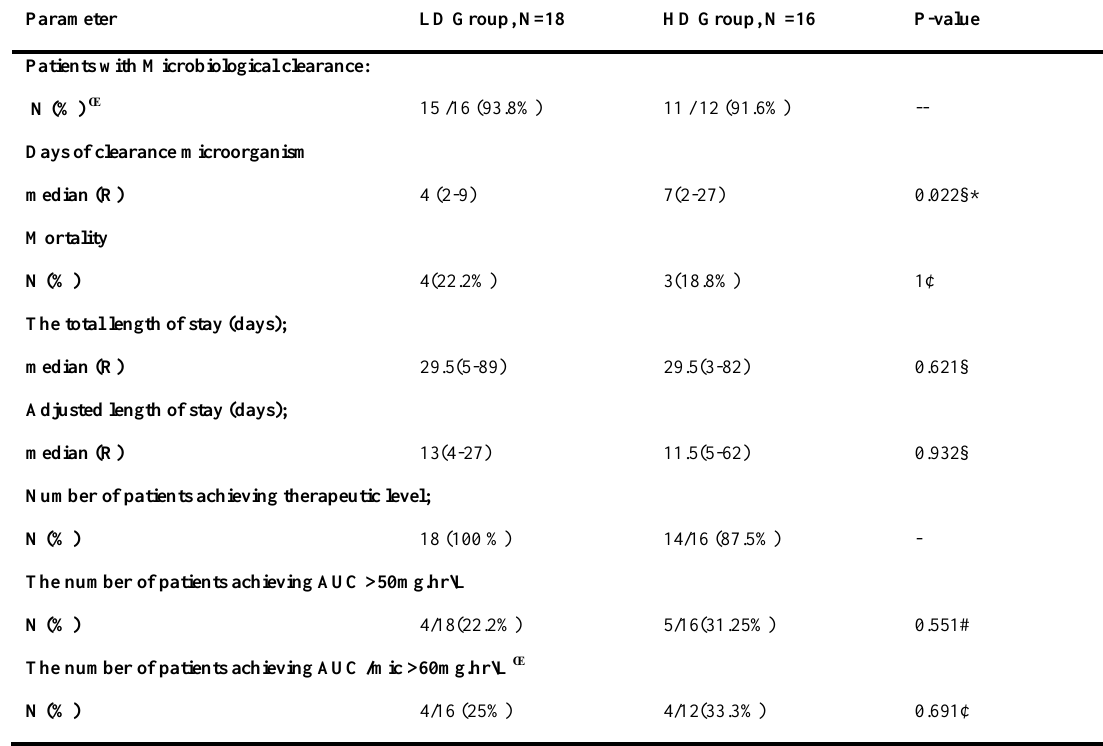
Table 4. Treatment Outcome of Febrile Neutropenic Pediatric Cancer Patients treated with colistin Parameter LD Group, N=18 HD Group, N =16